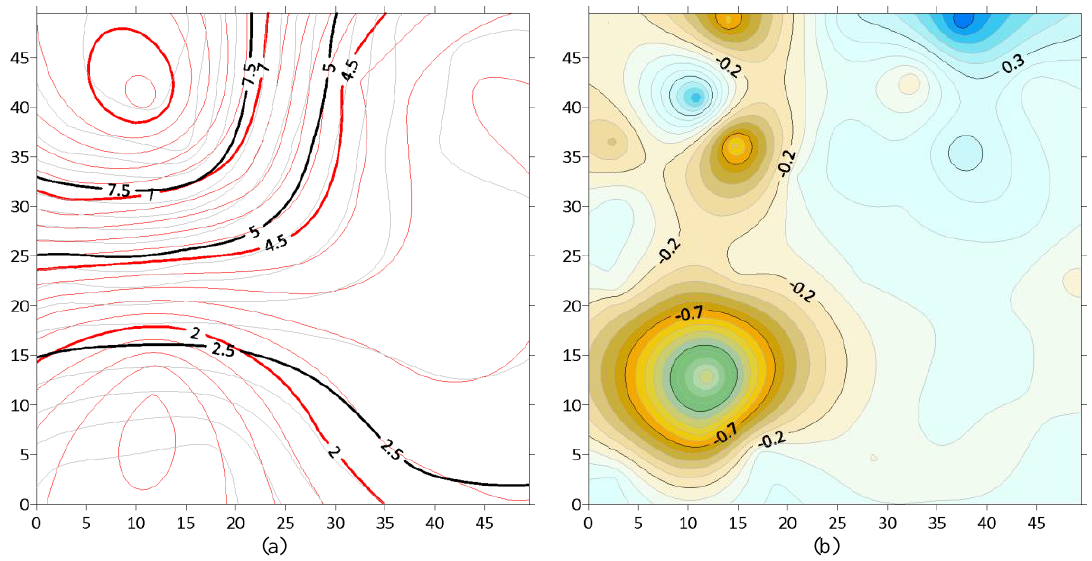
Figure 9. Contours ( a ) and volumetric surfaces ( b ) visual comparison.